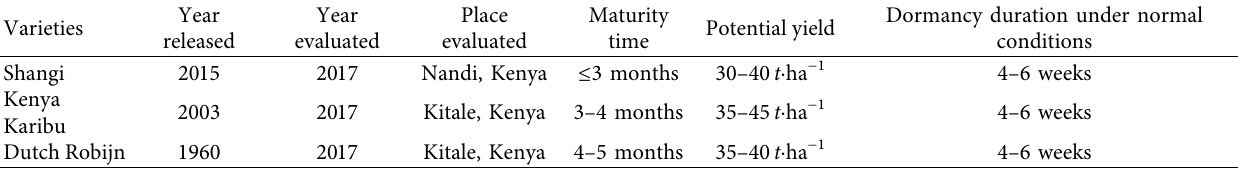
Table 1: Varieties are evaluated in this study and some of their